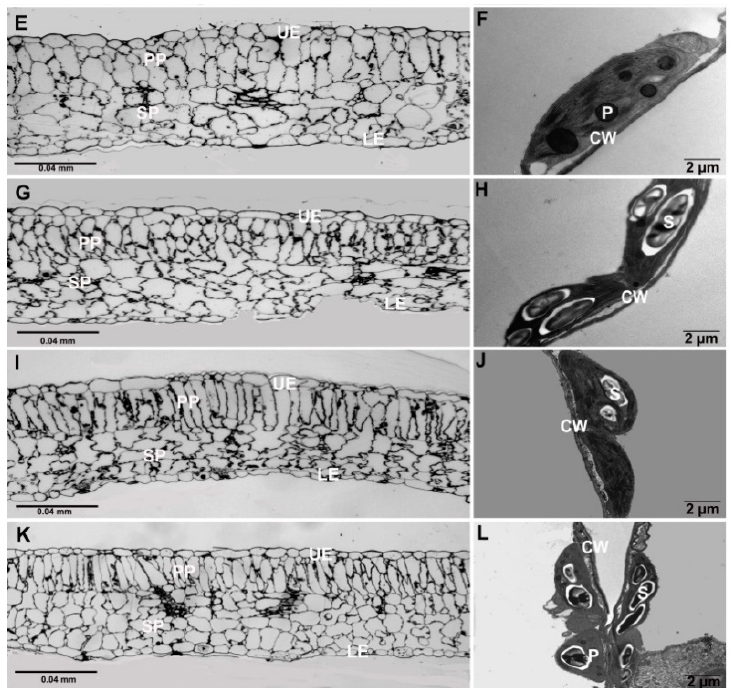
Figure 6. Thick and thin leaf sections of Solanum melongena . Light microscopy micrographs of control plants ( A ); NaCl-treated plants ( C , E , G , I , K ) did not show any visible deformation with intact upper and lower epidermis, palisade, and spongy layers. NaCl-treated plants 75–150 mM ( H , J , L ) exhibiting large amounts of starch grains. Micrograph images of 150 mM NaCl-treated plants ( L ) showed deformed thylakoid membranes associated with large starch grains. Cell wall (CW), upper epidermis (UE), palisade parenchyma layer (PP), spongy parenchyma layer (SP), plastoglobule (P), lower epidermis (LE), starch